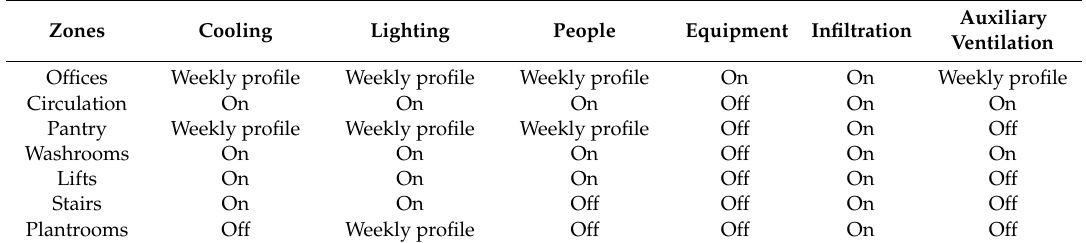
Table 4. Room profiles boundary